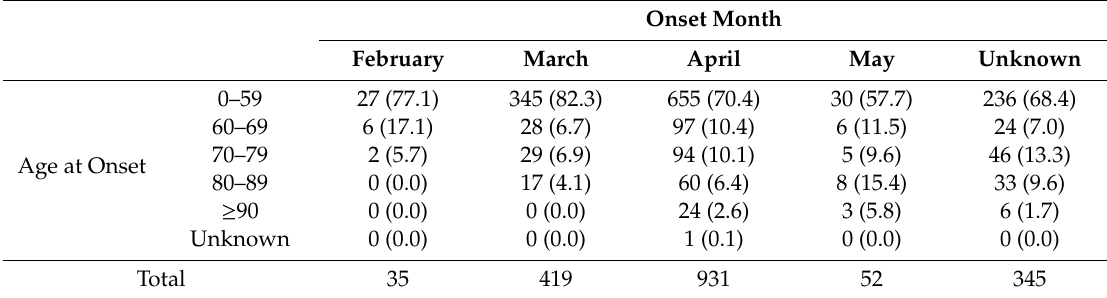
Table 2. Distribution of age group at the onset date according to the onset month.